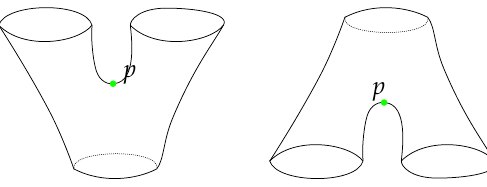
Figure 5. A split saddle on the left and a merge saddle on the